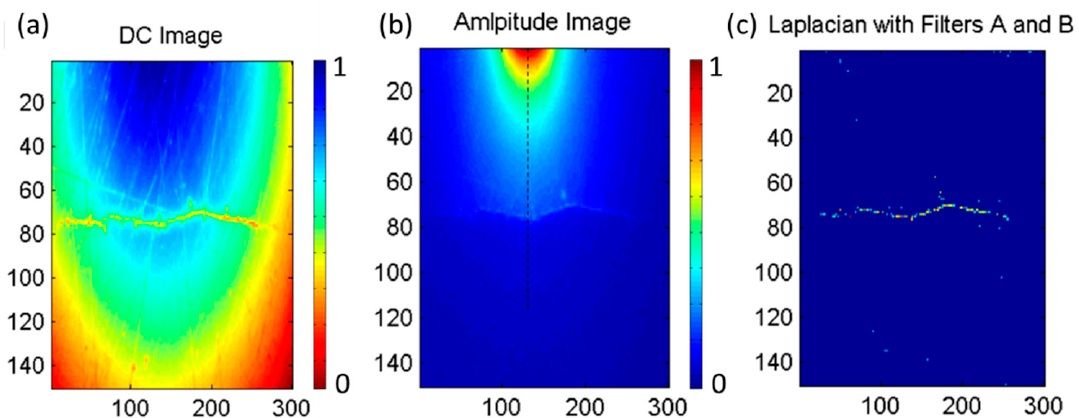
Figure 6. ( a ) DC image of a crack and surface scratches. Color map indicates the normalized relative temperature. ( b ) Lock-in amplitude image of the crack only with heating source. Color map indicates the normalized amplitude. Dashed line cuts the crack where the Laplacian is taken for crack sizing analysis in Figure 7b. ( c ) Processed lock-in amplitude image of the crack.